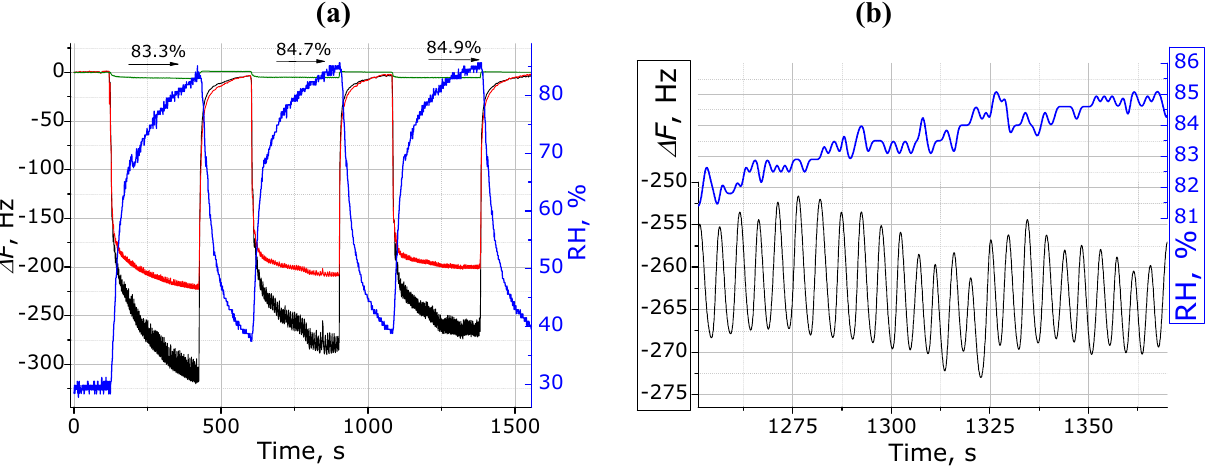
Figure 4. (a) QCM sensor reproducibility assessment and humidity influence on all channels response to breathing: green line, blank electrode; red line, (PDDA + /MnTSPP − ) black line, (PDDA + /TSPP − ) ; blue line, humidity change during breathing (right y-axis); 15 (b) Enlarged view of the sensor response compared to commercial humidity logger